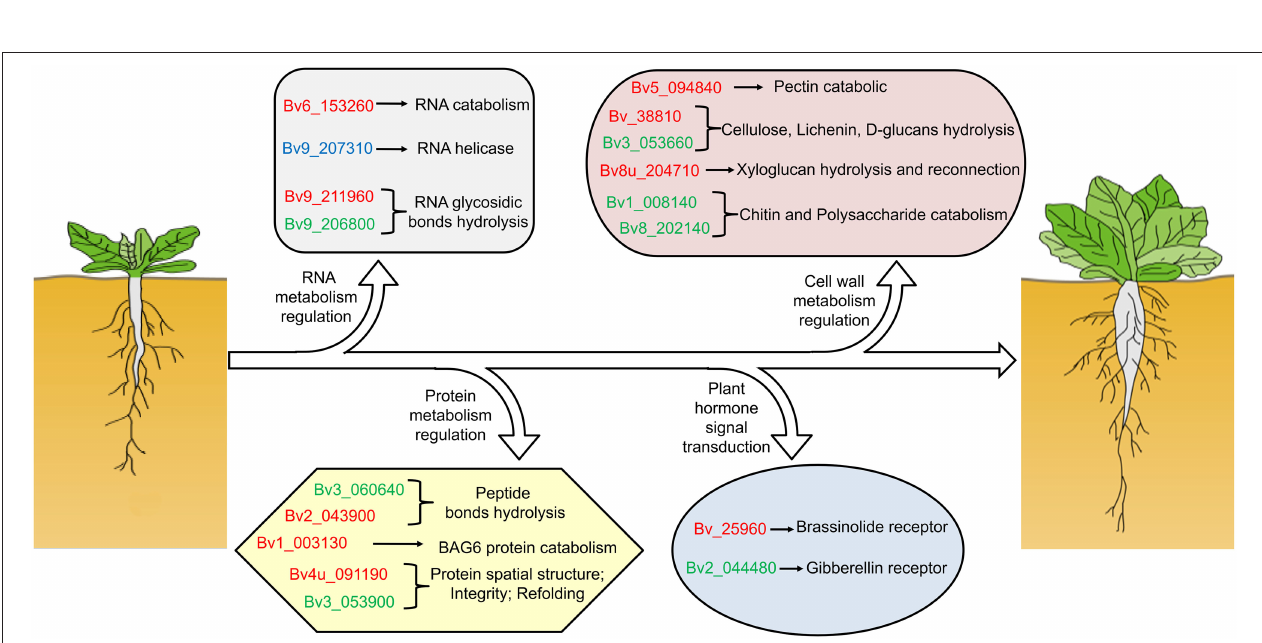
FIGURE 7 | Schematic diagram of the regulation of sugar beet taproot growth and development. Taproot growth and expansion might be regulated at RNA metabolism, protein metabolism, and cell wall metabolism. RNA metabolism relative genes promote RNA catabolism, RNA helicase, and RNA glycosidic bond hydrolysis to restrict the formation of proteins in many processes. Protein metabolism relative genes involved in peptide bonds hydrolysis, BAG6 protein catabolism, and protein spatial structure refolding and maintaining protein integrity to assist in the correct posttranslational assembly of proteins. Cell wall metabolism relative genes involved in pectin, chitin, cellulose, lichenin, D-glucans, xyloglucan hydrolysis, and reconnection, promote the loosening and elongation of the cell wall, and improve cell elongation or expansion. Brassinolide and gibberellin receptor genes are enriched in pathway of plant hormone signal transduction. The red font indicates upregulated, and the green font represents downregulated in both transcriptome and proteome; and the blue font represents downregulated in transcriptome and upregulated in proteome.